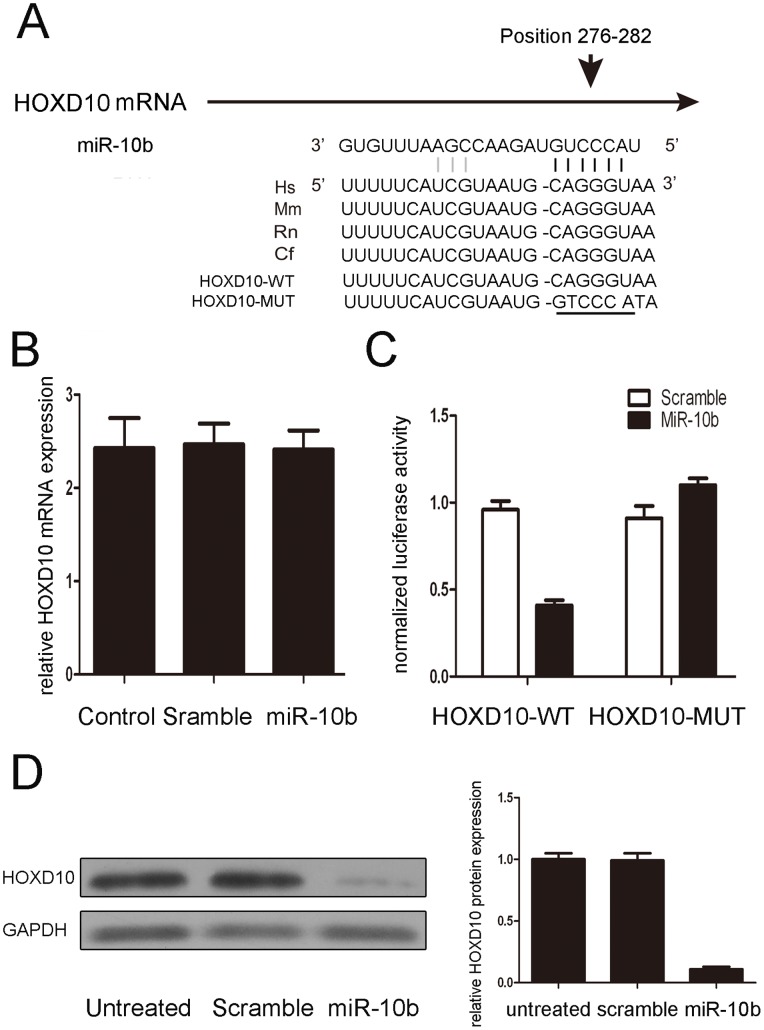
HOXD10 is a direct target of miR-10b.(A) Predicted duplex formation between human HOXD10 3′-UTR and miR-10b, HOXD10 3′-UTR is highly conserved in different species. Upper panel, sequence alignment of miR-10b with binding site on the HOXD10 3′-UTR. Lower panel, sequence of the miR-10b binding site within the HOXD10 3′-UTR of four species. (B) MiR-10b cannot alter mRNA level of miR-10b by real-time PCR. (C) Luciferase activity of wild-type (WT-UTR) or mutant (MUT-UTR). (D) HOXD10 protein expression in NP cells were transfected with 50 nmol/L of miR-10b mimics, sramble or not transfected.